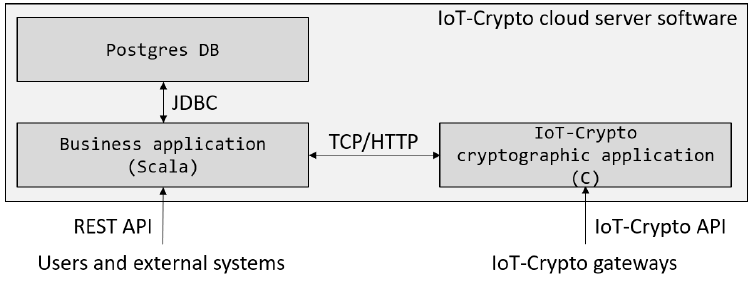
Figure 4. IoT-crypto server software structure.